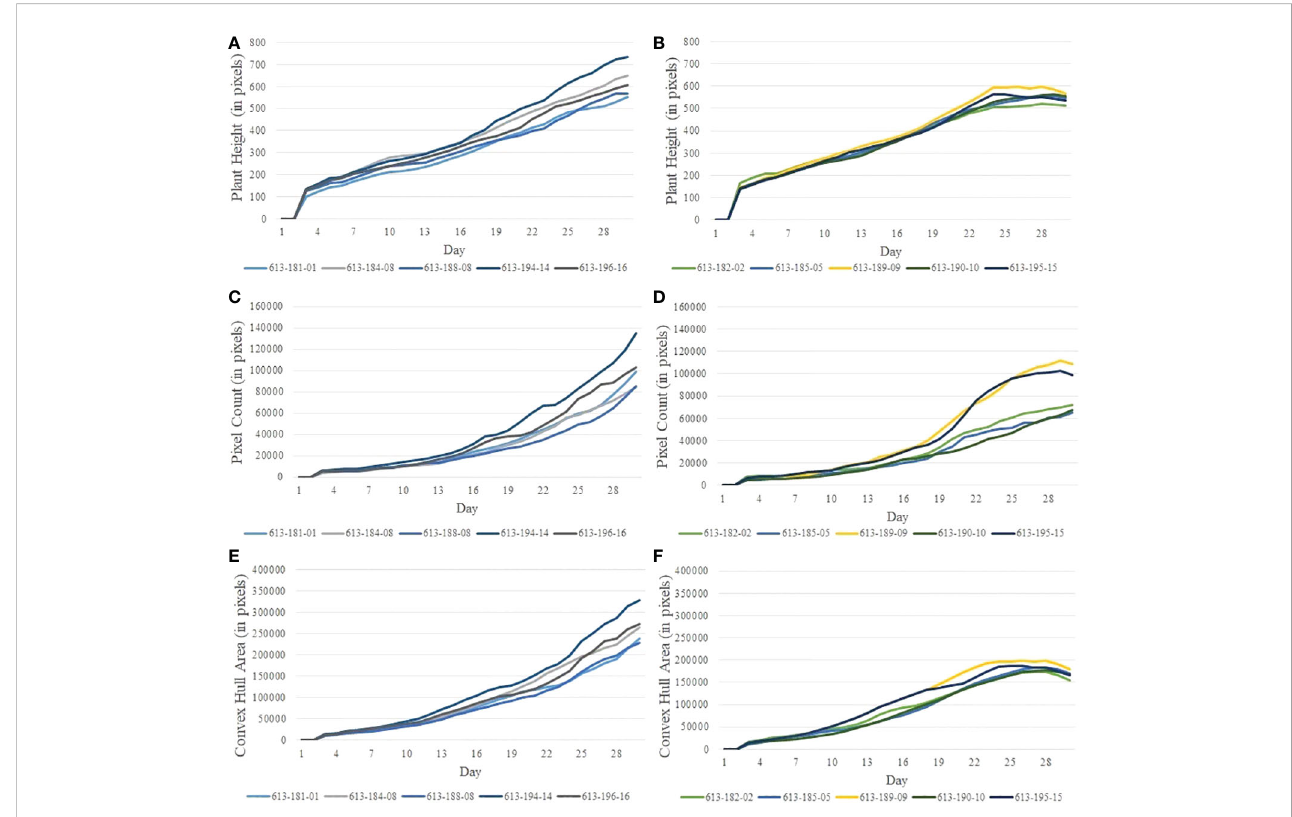
FIGURE 5 Illustration of smoothened time series using plants from Experiment 2. (A, B) plant height for control and stressed plants, respectively; (C, D) plant biomass (measured by pixel count) for control and stressed plants, respectively; and (E, F) plant size (measured by the area of convex hull enclosing the plant) for control and stressed plants,